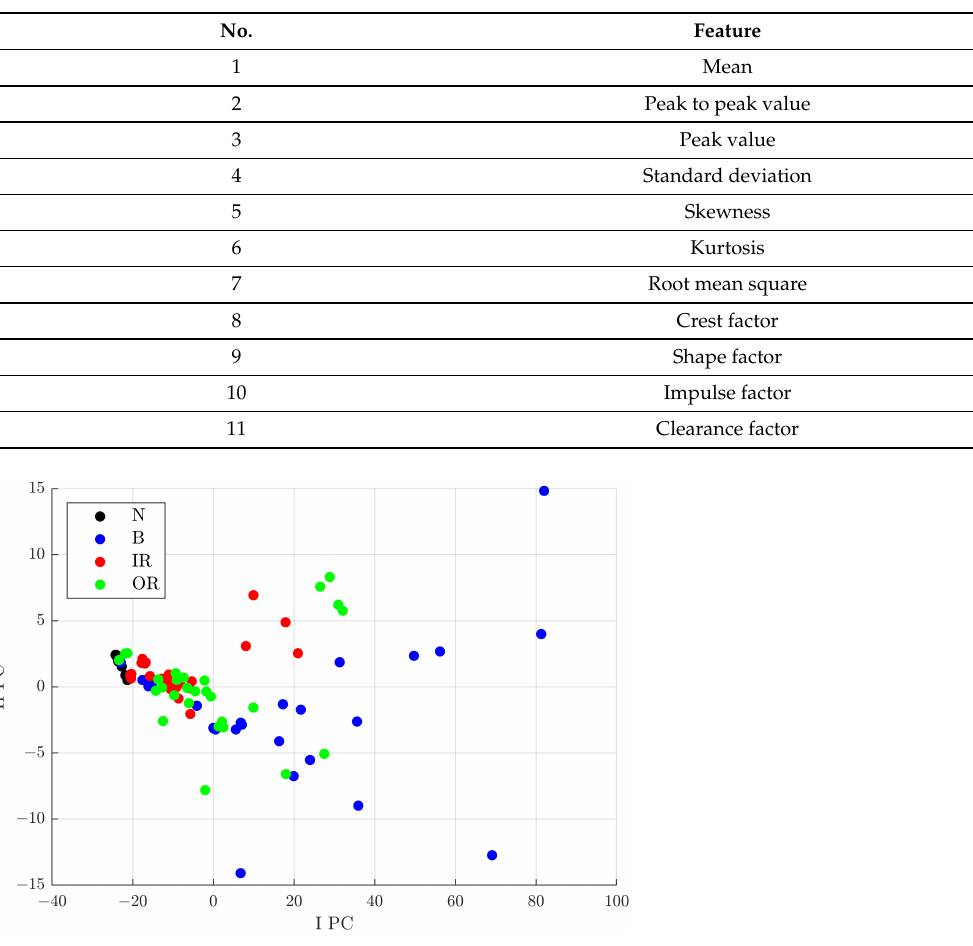
Figure 15. Distribution in the I PC–II PC plane of the analysed signals with respect to the charac- teristics selected by the Pareto method out of 11, calculated for 4 defect classes after denoising with Group